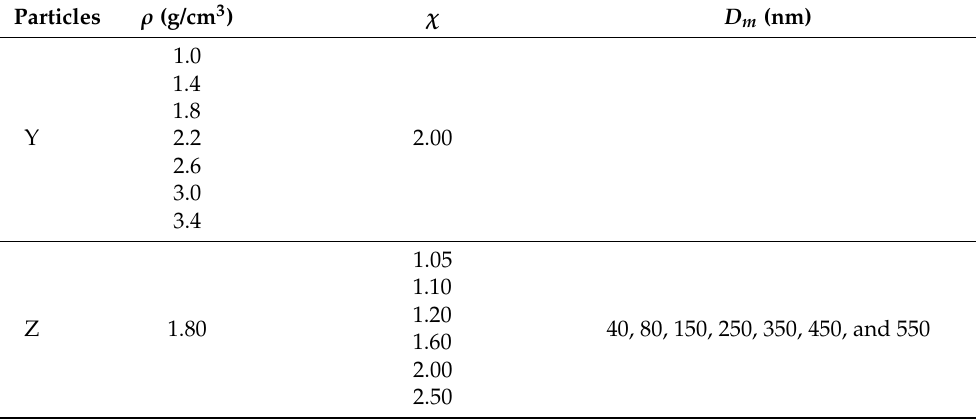
Table 1. Information ( ρ , χ , and D m ) for calculating the three ρ e for particles of Y and Z. Particles ρ (g/cm 3 )